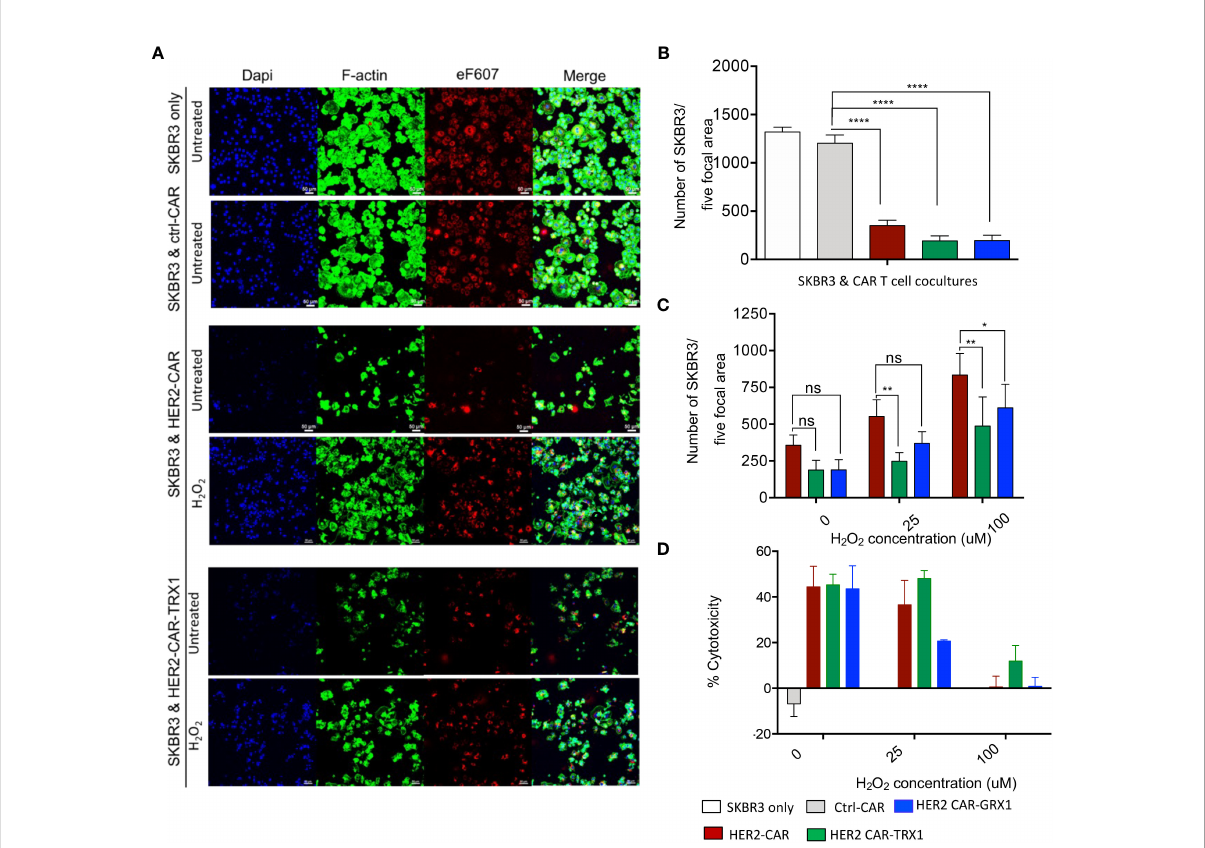
FIGURE 3 Cytotoxicity of HER2-CAR T cells and Grx1-, and TRX1-enhanced HER2-CAR T cells under pro-oxidative conditions. (A) SKBR3 tumor cells were pre-stained with eF607 (red) and seeded on coverslips. The next day, ctrl-CAR T cells, HER2-CAR T cells, or antioxidant-enhanced HER2-CAR T cells were added onto the coverslips and cocultured for 24 h. Then, cells were stained for nuclei (DAPI, blue), and F-actin (phalloidin, green). Large scan (3 x 3 xy ) images were acquired using a 20x objective and cells from fi ve focal planes quanti fi ed (n = 3). (B) Quanti fi cation of SKBR3 cells in fi ve focal planes. Percentage of SKBR3 cells in cocultures were calculated by taking the ratio of the number of SKBR3 cells in coculture to that of SKBR3 cells under control (SKBR3 only) conditions (n = 4). (C) Quanti fi cation of SKBR3 cells in fi ve focal planes (n = 4). After coincubation (24 h) of untreated or H 2 O 2 -pre-treated HER2-CAR, HER2-CAR-TRX1, and HER2-CAR-GRX1 T cells in a 5:1 ratio with SKBR3 cells, a microscopy-based cytotoxicity assay was performed. Data represent mean ± SEM (n ≥ 3; * p < 0.05, ** p < 0.01). (D) LDH release assay showing percentages of CAR T cell cytotoxicity to tumor cells at the indicated CAR T cell:tumor cell ratios. Untreated or H 2 O 2 -pre-treated CAR T cells and SKBR3 cells were coincubated at the indicated ratios for 24 h. LDH activity in supernatants was determined by measuring spectrophotometric absorbance at 490 nm (n = 3). Data represent mean ± SEM (n ≥ 3; * p < 0.05, ** p < 0.01, **** p < 0.00001, ns = non-signi fi